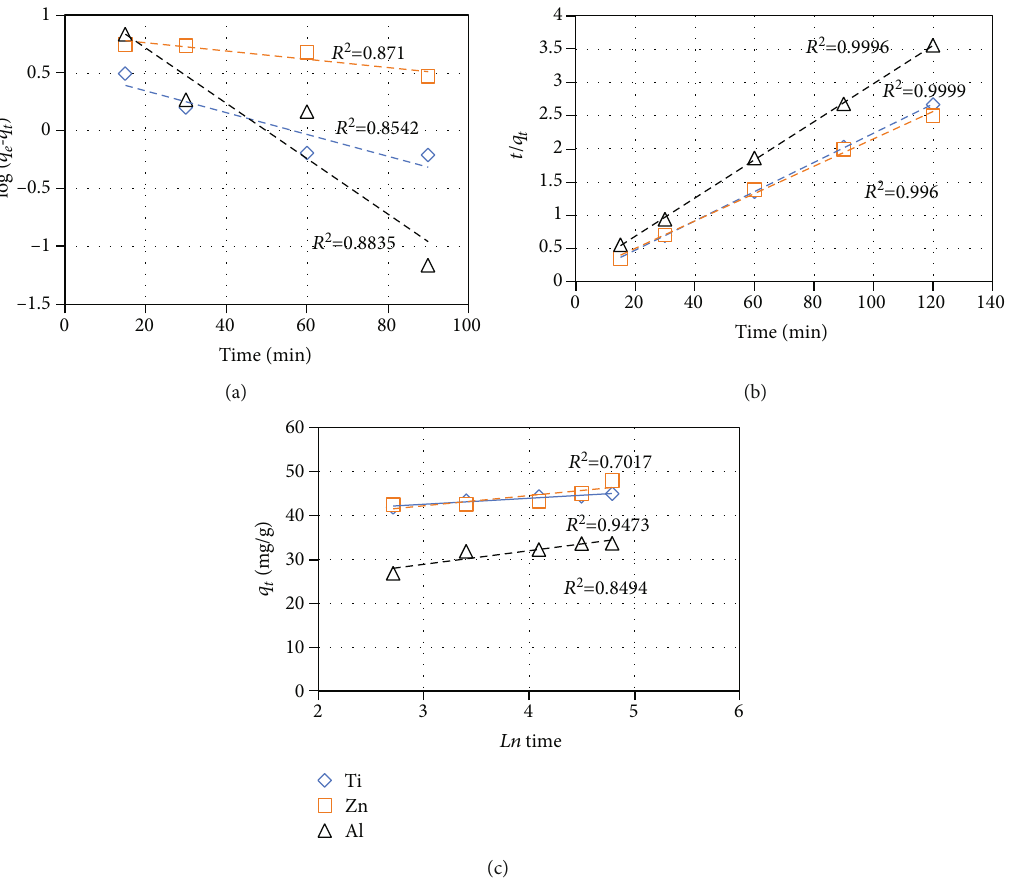
Figure 4: Models for the kinetics of Pb(II) adsorption onto all adsorbents: (a) PFO, (b) PSO, and (c) Elovich ’ s equation. Table 1: Kinetic parameters for adsorption of Pb(II) onto di ff erent adsorbents using PFO, PSO, and Elovich equation. Kinetic